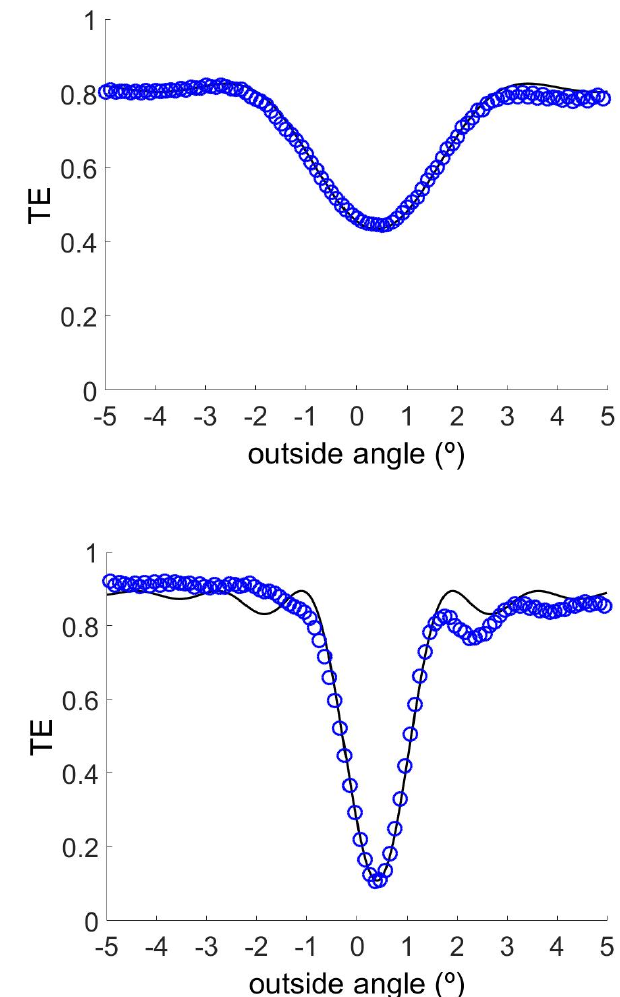
Figure 4. Angular responses for gratings recorded with the different chemical compositions ( a ) Solution 0; ( b ) Solution 1; ( c ) Solution 2 and ( d ) Solution 3.